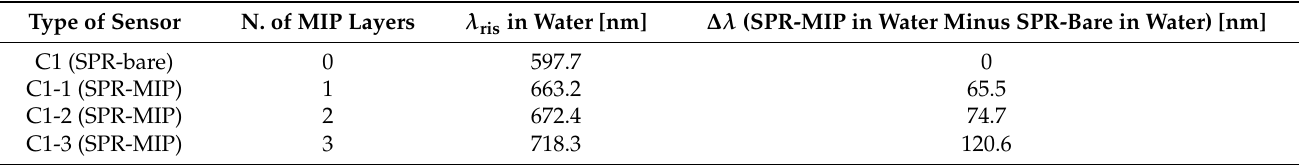
Figure 4. Transmission spectra of C1 (SPR-MIP) platform, with one, two, or three MIP layers, in water, normalized on the spectrum of the corresponding platforms in air.